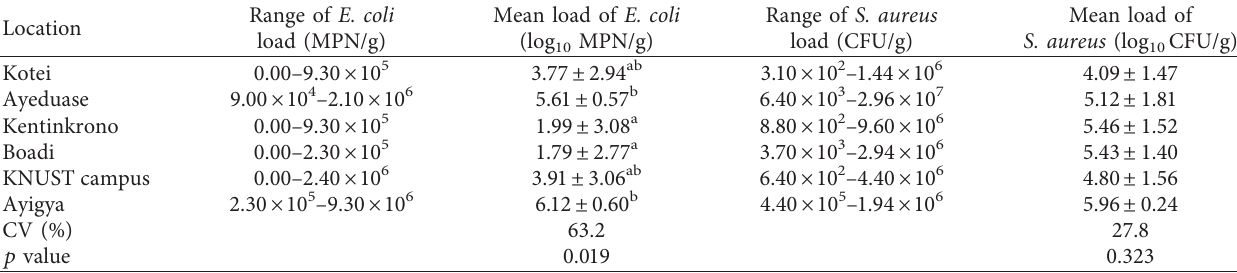
Table 1: Mean loads of E. coli and S. aureus in beef khebab sold on the KNUST campus and its environs. Range of E. coli Location